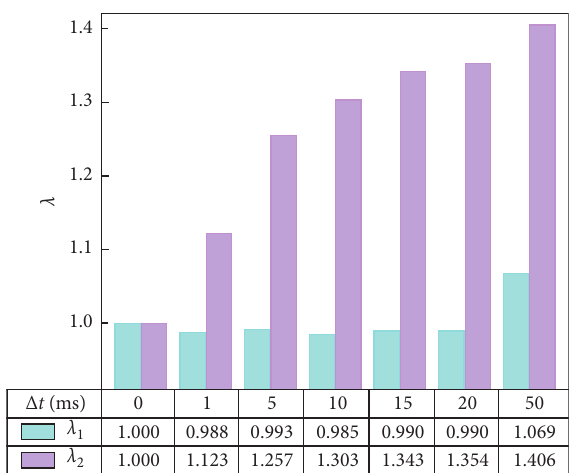
Figure 10: Analysis models with different delay